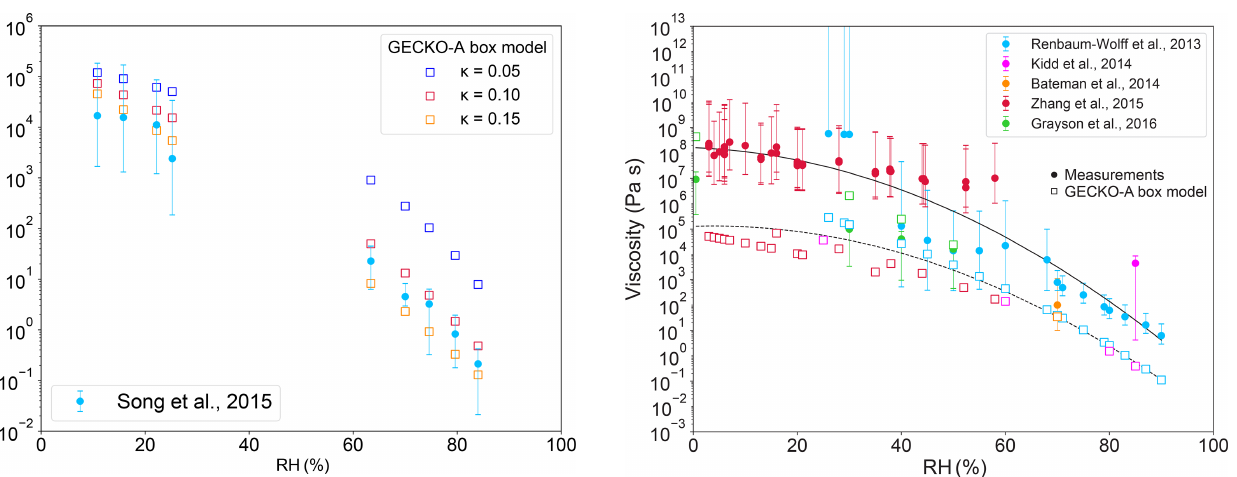
Figure 2. Comparison of measured (solid markers) and simulated (open markers) viscosity of α -pinene SOA as a function of RH. For each set of laboratory experiments the measured viscosities are re- ported with uncertainties. The solid and dashed lines represent the polynomial regression for measurements and model simulations, re- spectively, to guide